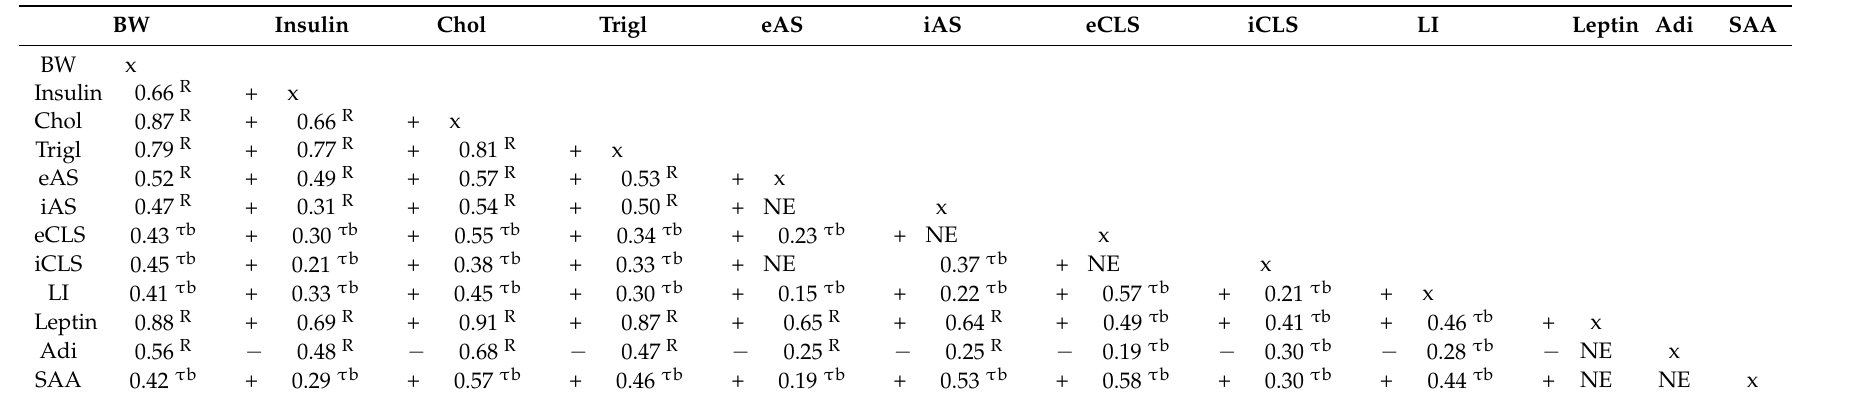
Table 3. Correlation coefficients among late-adult